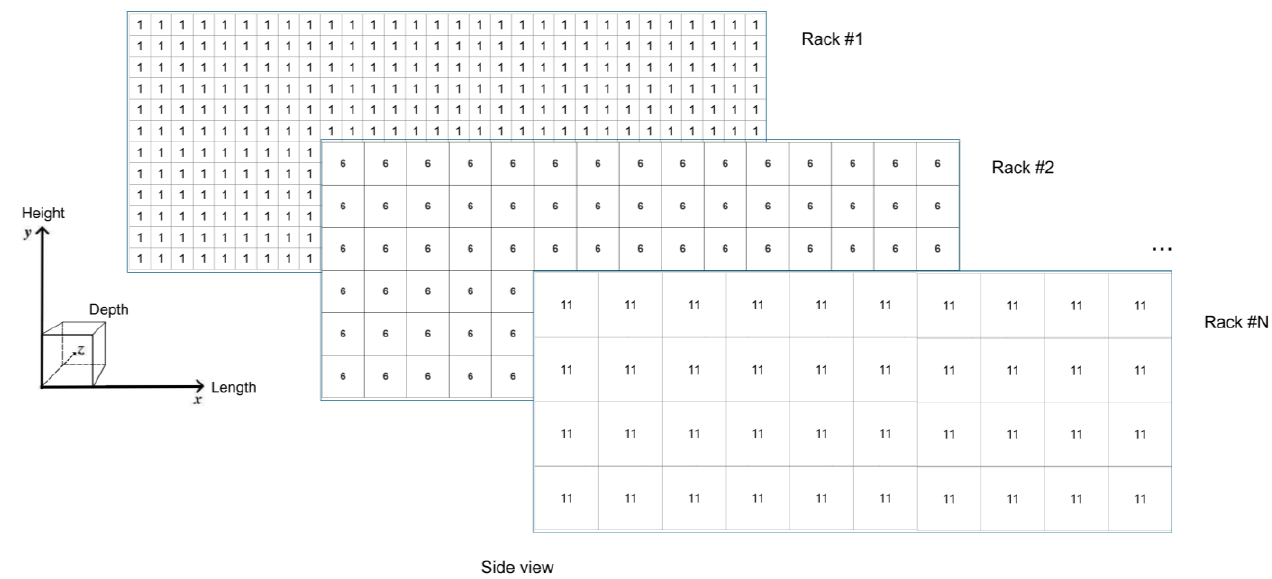
Figure 3. The side view of Type B racks.